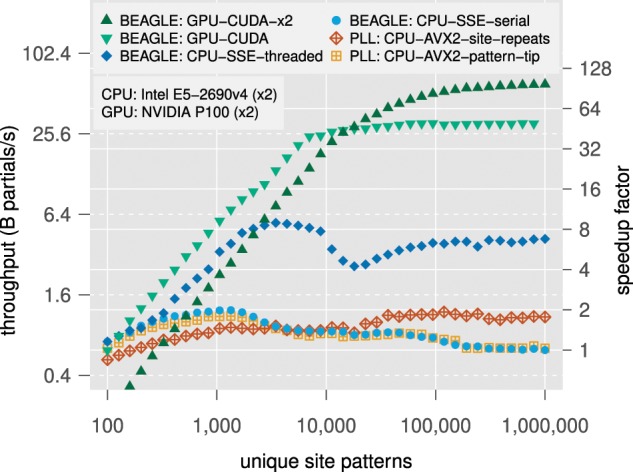
Absolute (throughput in billions of partial likelihood calculations per second) and relative (fold-speedup relative to the slowest performance observed at any number of unique site patterns) performance scaling with problem size for implementations of the BEAGLE library Version 3.1.2 and the Phylogenetics Likelihood library Version 2 on nodes of the Comet Supercomputer available via CIPRES. The data are simulated nucleotide sequences for a tree of 128 OTUs.